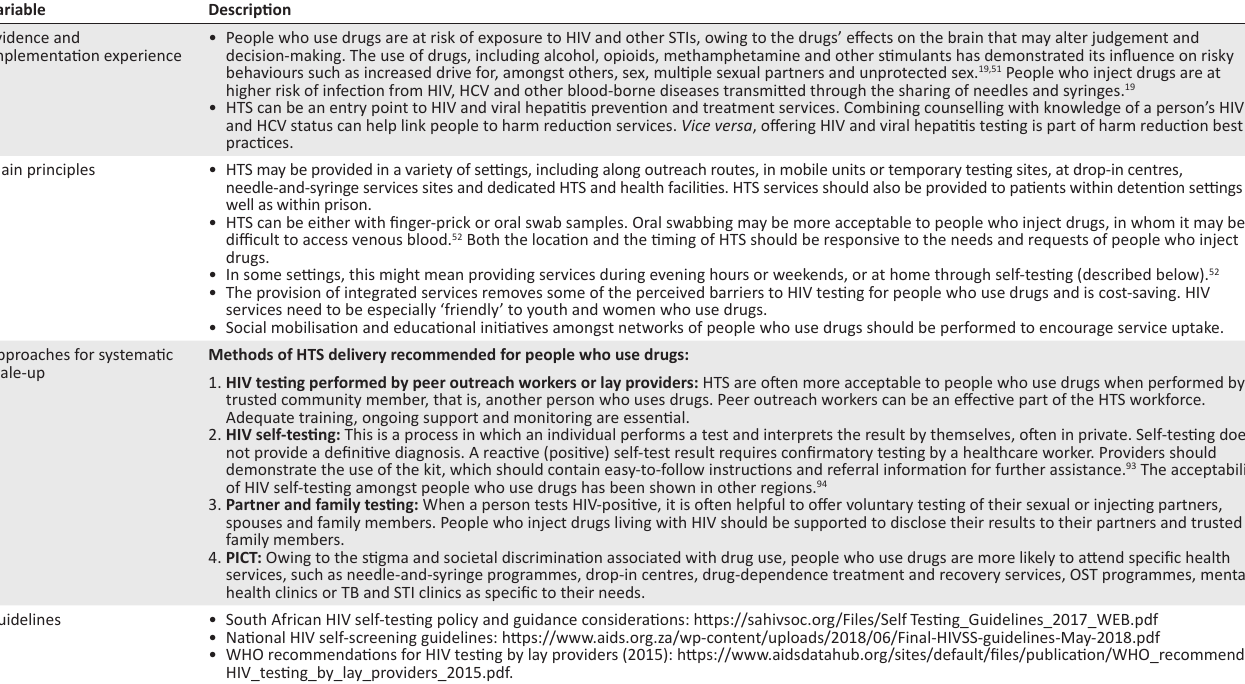
TABLE 18: HIV testing treatment and care – HIV testing and counselling. 19 Variable